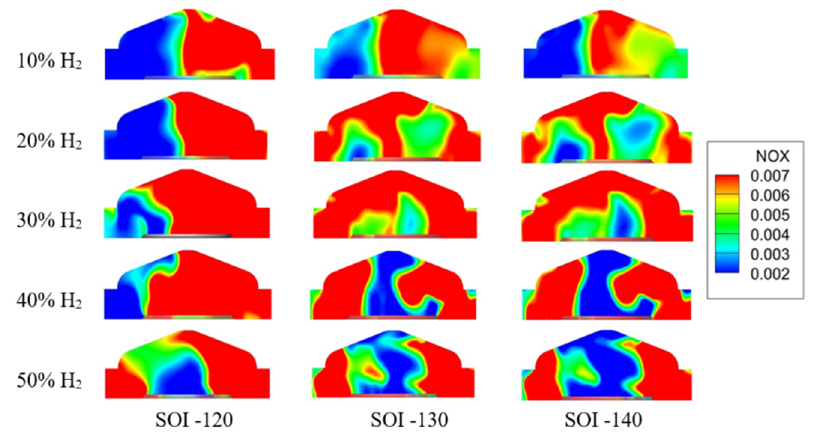
Figure 12. Contours of NO X emissions for different case studies at 40 CAD aTDC.